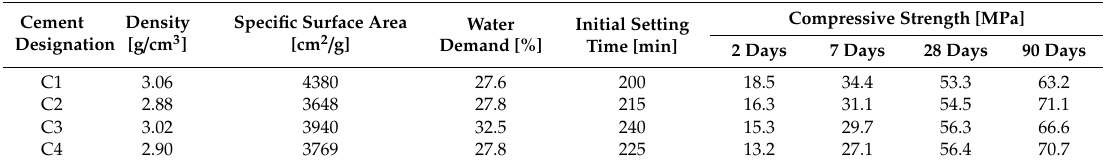
Table 6. Standard properties of cements.